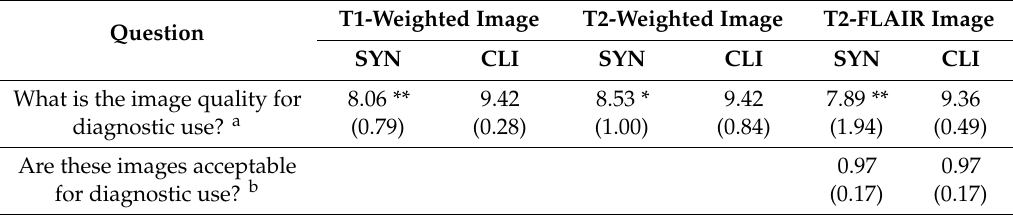
Table 3. Diagnostic image quality rated by two